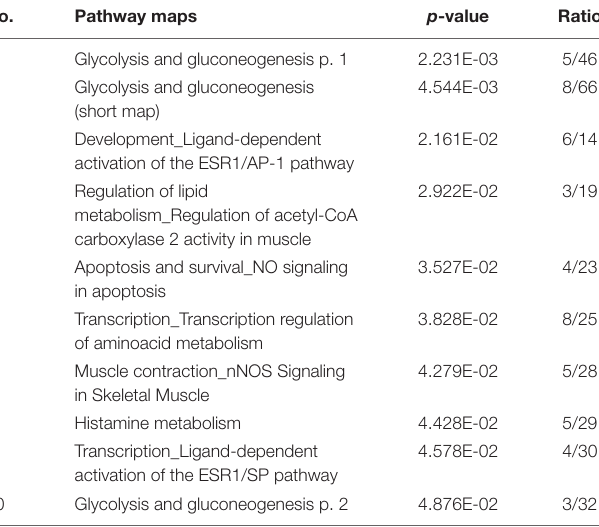
TABLE 1 | Enrichment analysis of LA gene expression in response to RAP. TABLE 2 | Enrichment analysis: Rat RAP vs. Human AF.